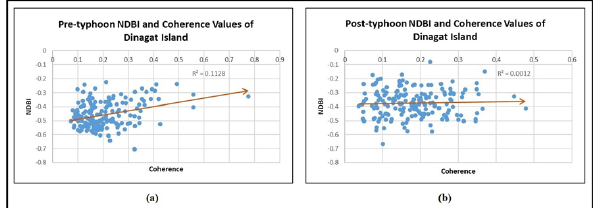
Figure 15 . Graph showing the relationship between NDBI and coherence values of Dinagat Islands